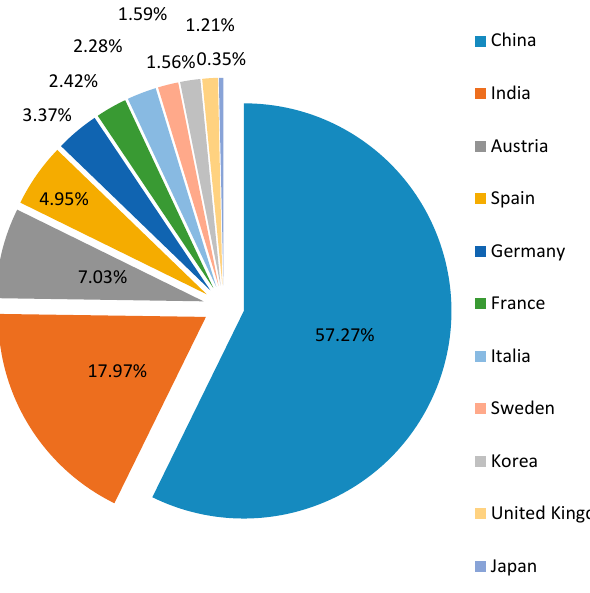
Figure 8. Biggest import partners in 2013.